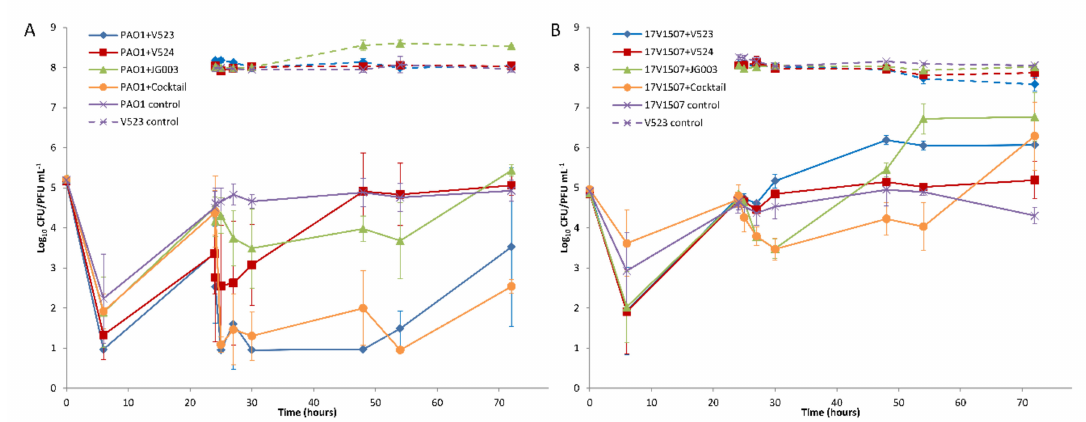
Figure 6. The effect of phages on ( A ) the P. aeruginosa PAO1 strain and ( B ) the environmental strain 17V1507. Three separate phages and the phage cocktail were tested. The phages were added after 24 h. Host (solid lines) and phage (dashed lines) numbers were determined from triplicate experiments, and the error bars indicate standard deviations.